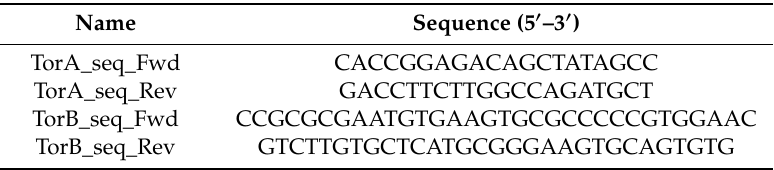
Table 2. Primers used for amplification of targeted